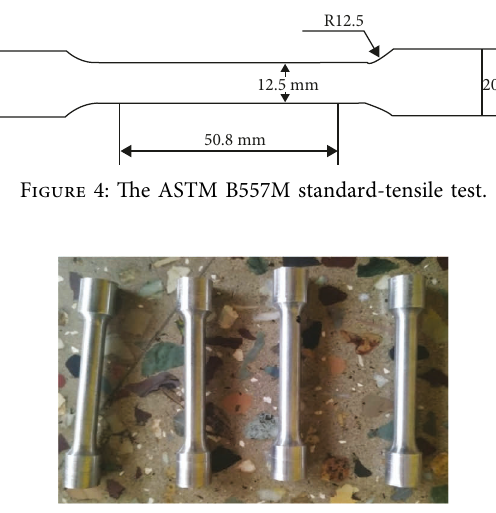
Figure 5: Some of the tensile test